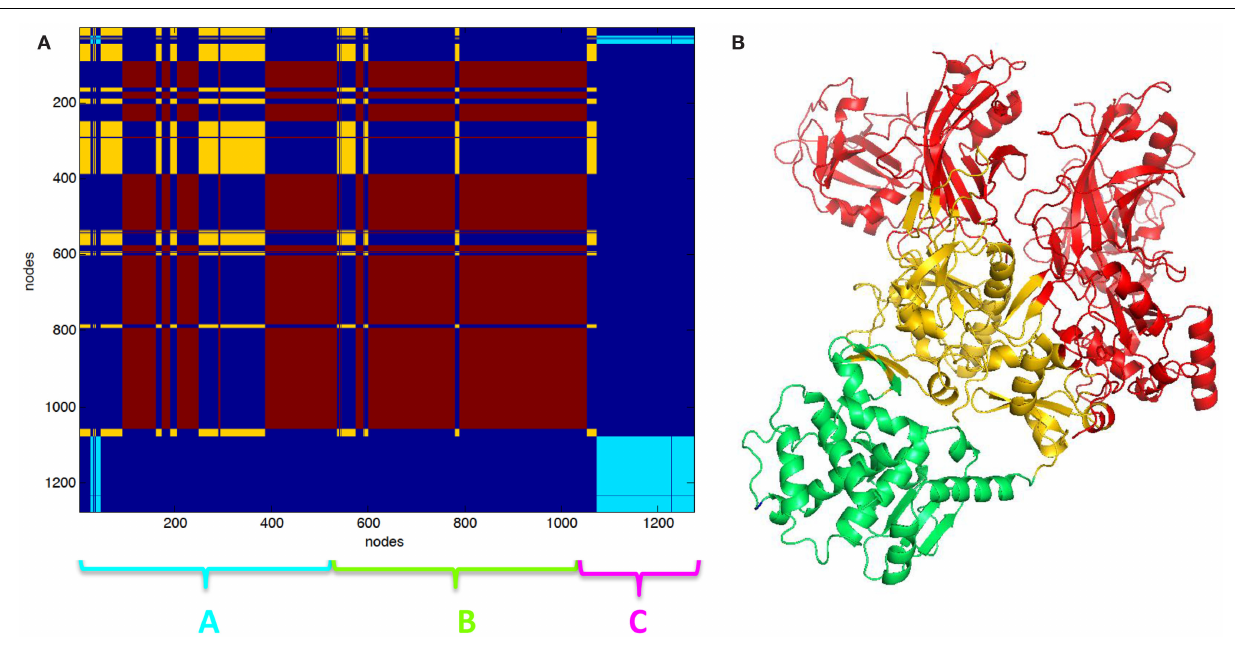
Frontiers in Bioengineering and Biotechnology |